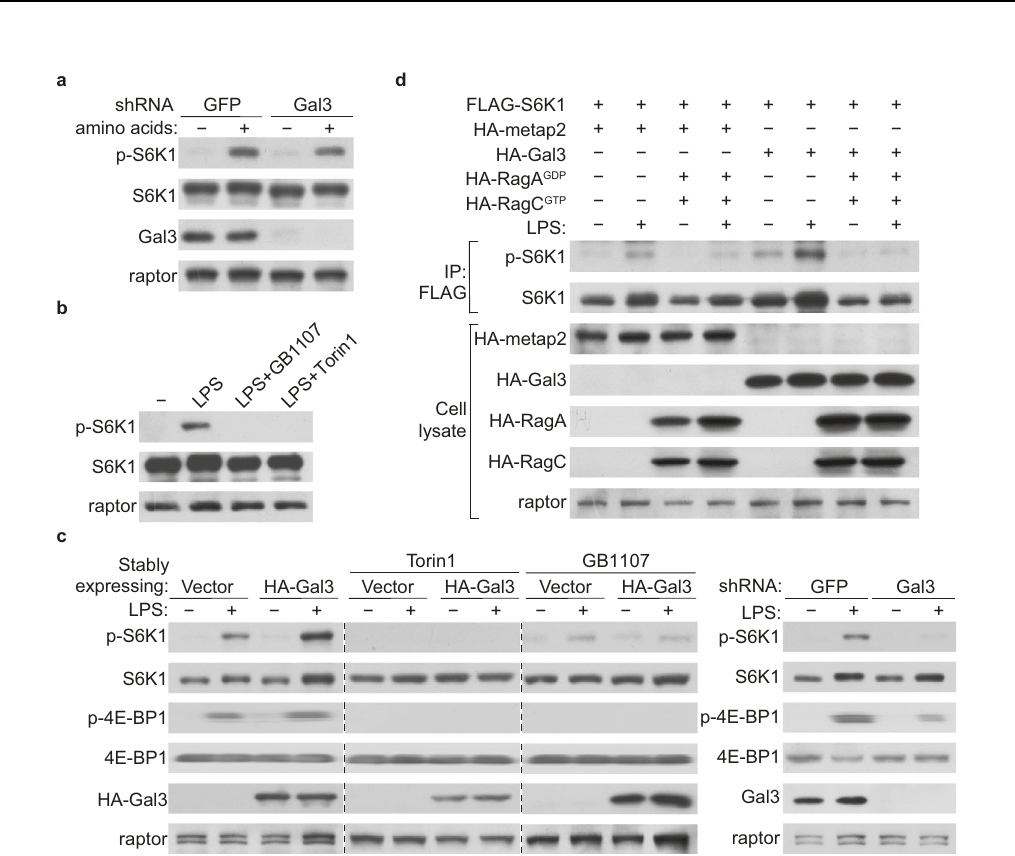
Fig.3|Galectin-3sensesLPStoactivatemTORC1.a HEK-293Tcellswereinfected with lentiviruses carrying shGFP or shGal3, starved of amino acids for 50min, and replenishedwithaminoacidsfor10minforwesternblottinganalysisofthelevelor phosphorylation of the indicated proteins. Each experiment was repeated three timeswithsimilarresults. b HEK-293Tcellswerestarvedofaminoacidsandglucose for1hfollowedbystimulationwithLPS(1 μ g/ml)for5hinthepresenceorabsence of the mTOR inhibitor Torin1 (250nM) or galectin-3 inhibitor GB1107 (5 μ M) for westernblotting analysisof the level or phosphorylation of the indicated proteins. Each experiment was repeated three times with similar results. c HEK-293T cells were infected with lentiviruses carrying shGFP or shGal3, or HA-Vector or HA-Gal3